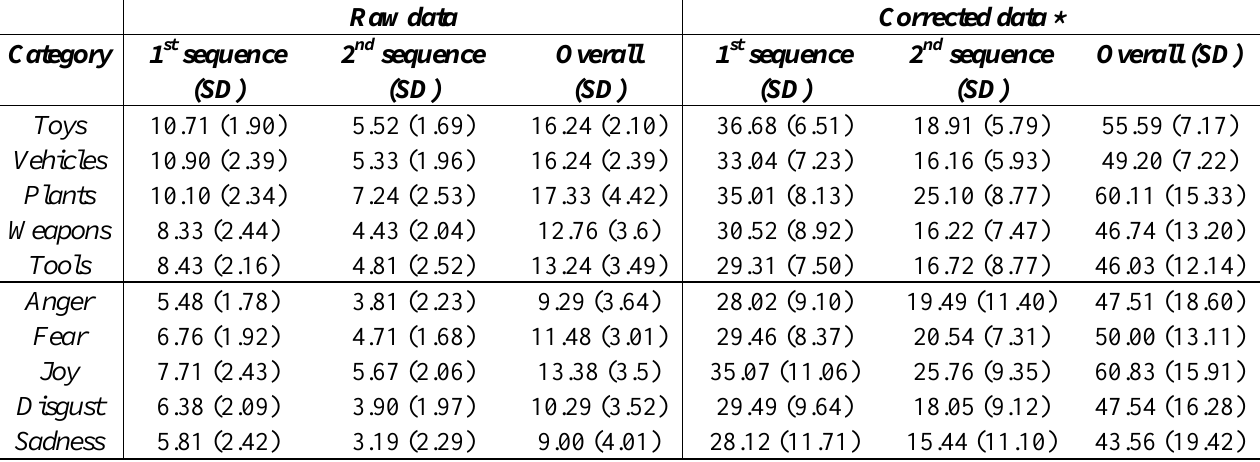
Table 4. Mean number of items (per task sequence and in total; raw and corrected data) and standard